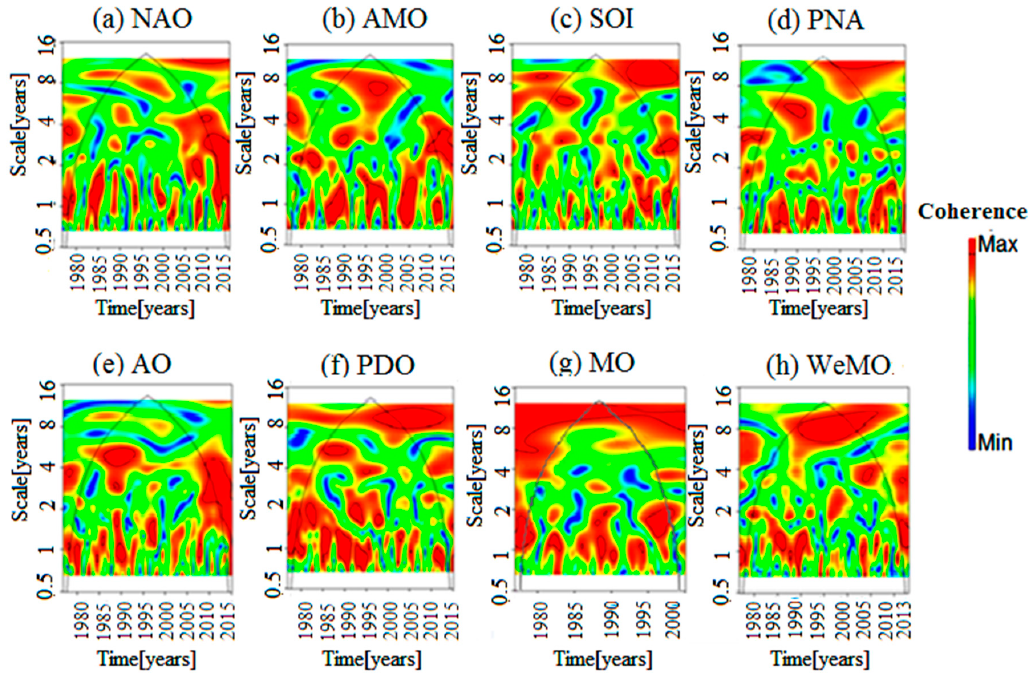
Figure 9. Spectrum of Wavelet coherence for climate indices and precipitation in station 5. ( a ) NAO: North Atlantic Oscillation, ( b ) AMO: Atlantic Multidecadal Oscillation, ( c ) SOI: Southern Oscillation Index, ( d ) PNA: Pacific–North-America teleconnection, ( e ) AO: Arctic Oscillation, ( f ) PDO: Pacific Decadal Oscillation, ( g ) MO: Mediterranean Oscillation, ( h ) WeMO: West Mediterranean Oscillation.